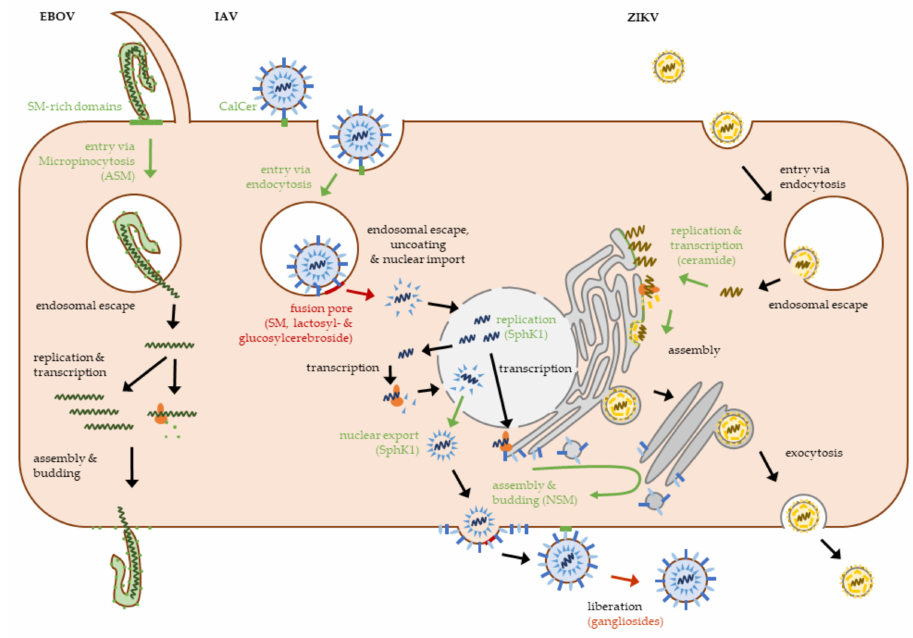
Figure 3. Role of sphingolipids in ebola-, influenza- and Zika virus replication. The life cycles of ebola virus (EBOV), influenza A virus (IAV) and Zika virus (ZIKV) show some of the diversity of viral replication and summarize key steps in which sphingolipids play a role in the viral life cycle. Supporting roles, i.e., the virus using sphingolipid-domains for cell entry or the formation of replication sites, are highlighted in green. Inhibitory roles are marked in red. ASM: acid sphingomyelinase, NSM: natural sphingomyelinase, SM: sphingomyelin, SphK1: sphingosine